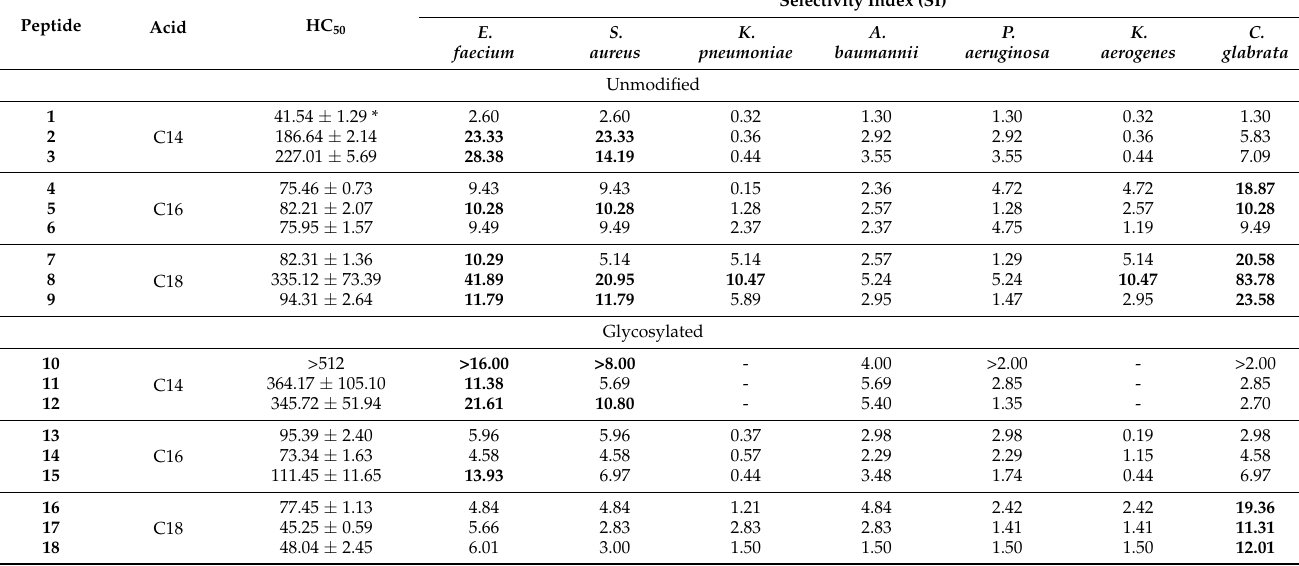
Table 4. Hemolytic activity (HC 50 [ µ g/mL]) and selectivity indexes of 1 – 18